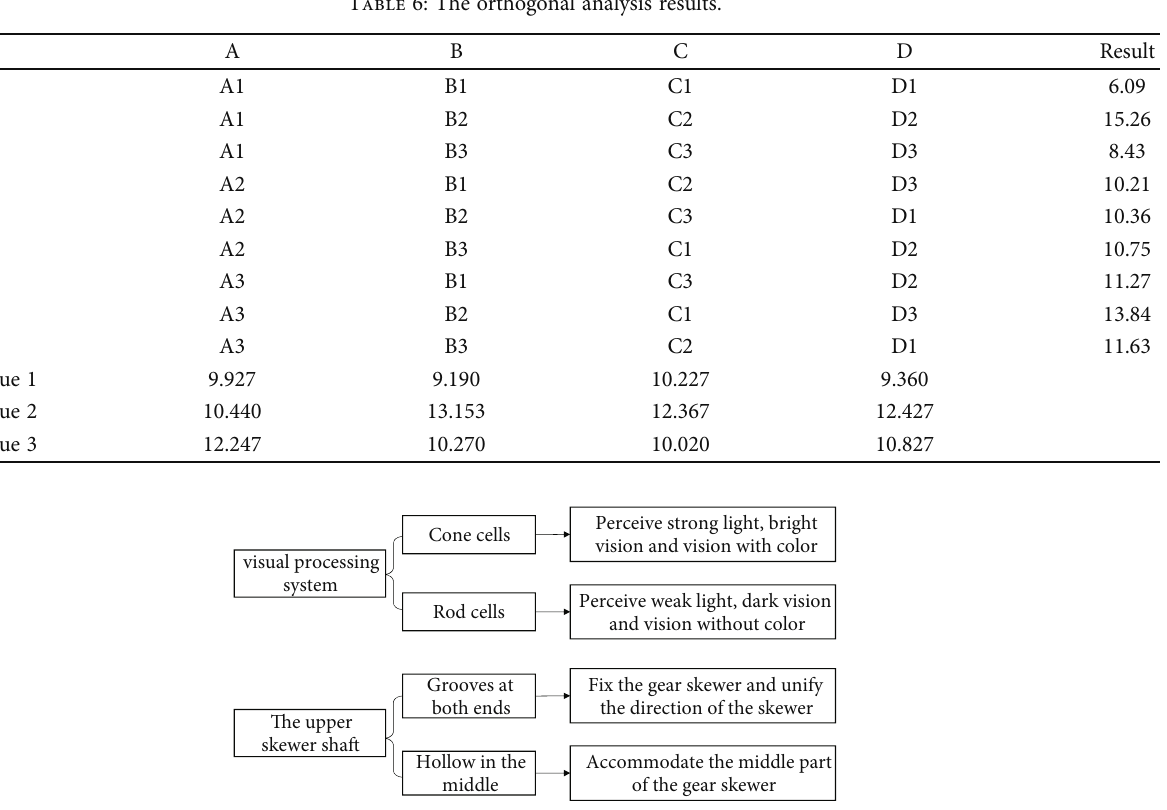
Table 6: The orthogonal analysis results.